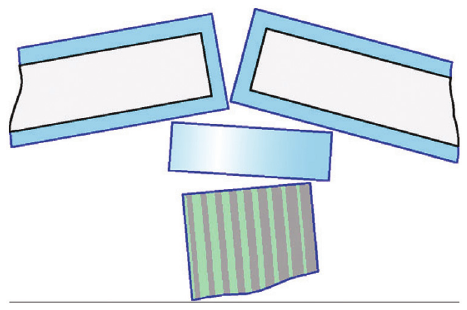
Figure 3: Contact